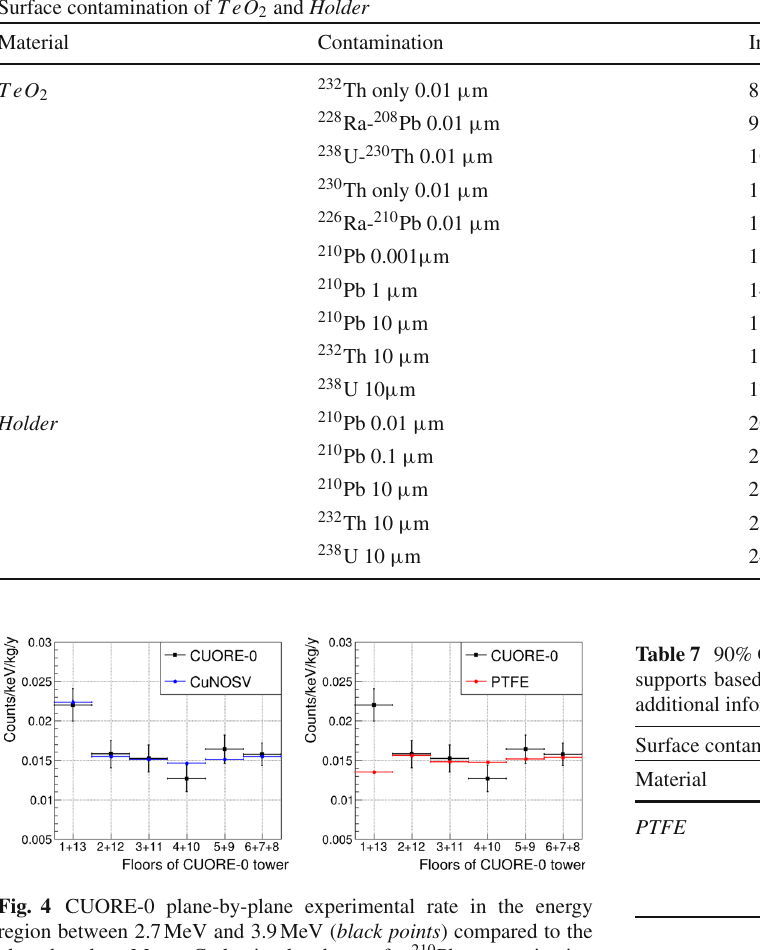
in all other cases single isotopes or sub-chains of 232 Th and 238 U are considered. Each contaminant is assigned a unique index for future reference